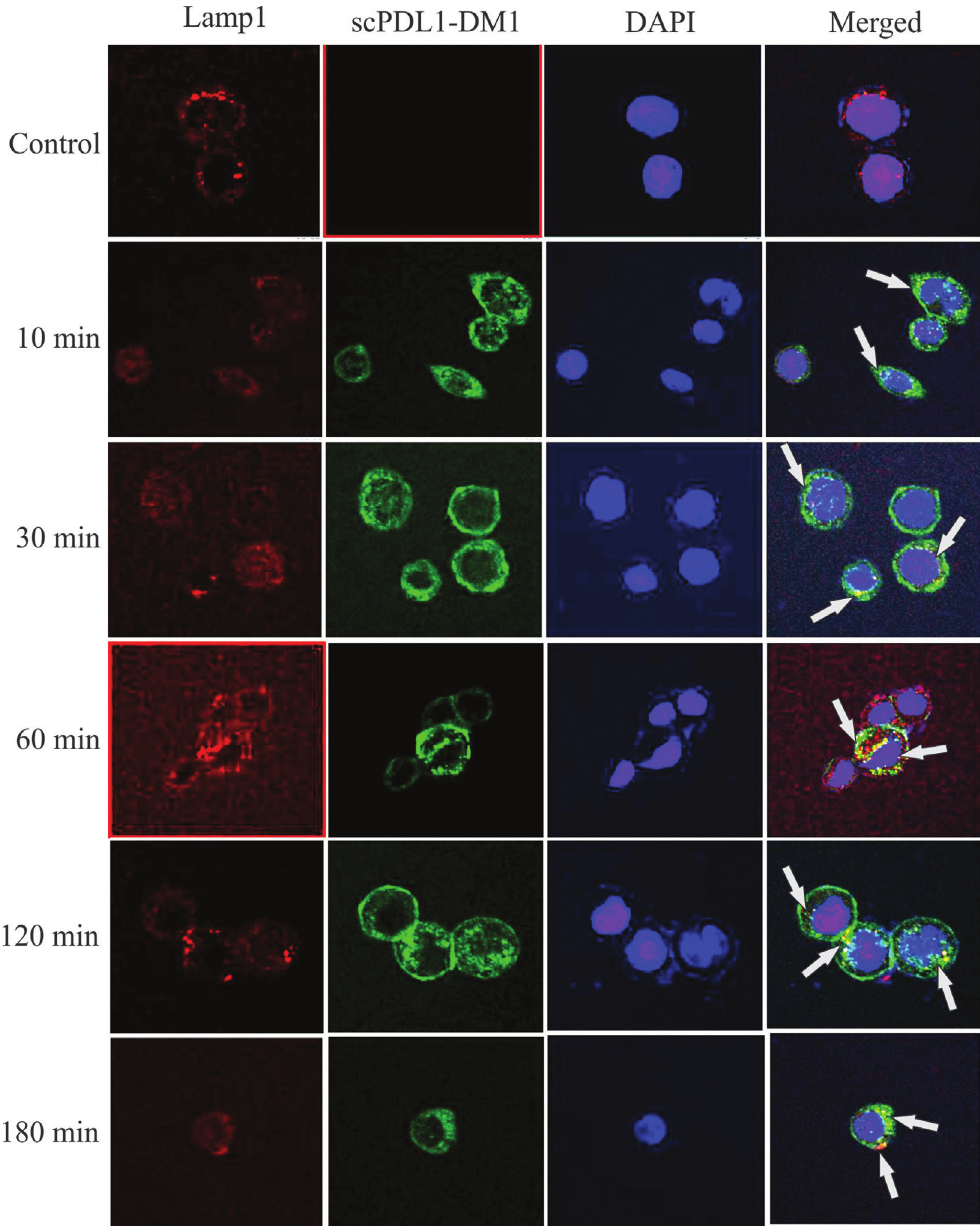
Figure 9 - Immunofluorescence analysis of scFv-PD-L1 drug trafficking. A549 cells were loaded on cover slides and incubated with the drug at different time intervals for surface localization and trafficking studies followed by FITC conjugated second antibody. Mouse monoclonal Lamp1 antibody was loaded to bind with lysosomes and counterstained with anti-mouse secondary antibody Alexa 488 conjugated. DAPI was loaded to stain the nuclei. Compparative accumulation of fluorescent signals within cellsindicates scPDL1-DM1 drug conjugates. In the first panel, there was no overlay in the mergewithnosignalsonsurfacesofcontrolcellline.At10minutesinterval,thebindingstartandtraffickingwereobserved.After2hoursmaximumtraf- ficking to lysosomes was observed with slight returning back of drug to surface. At 3 hours of incubation the surface localization increase that indicates the maximum returning back of drugs to the cell surface. The arrows indicate overlay of scPDL1-DM1 and trafficking in lysosomes. Photographs were taken with 63x oil immersion objective using Zeiss fluorescence microscope (Zeiss, Germany) in the core facility of Zhejiang University